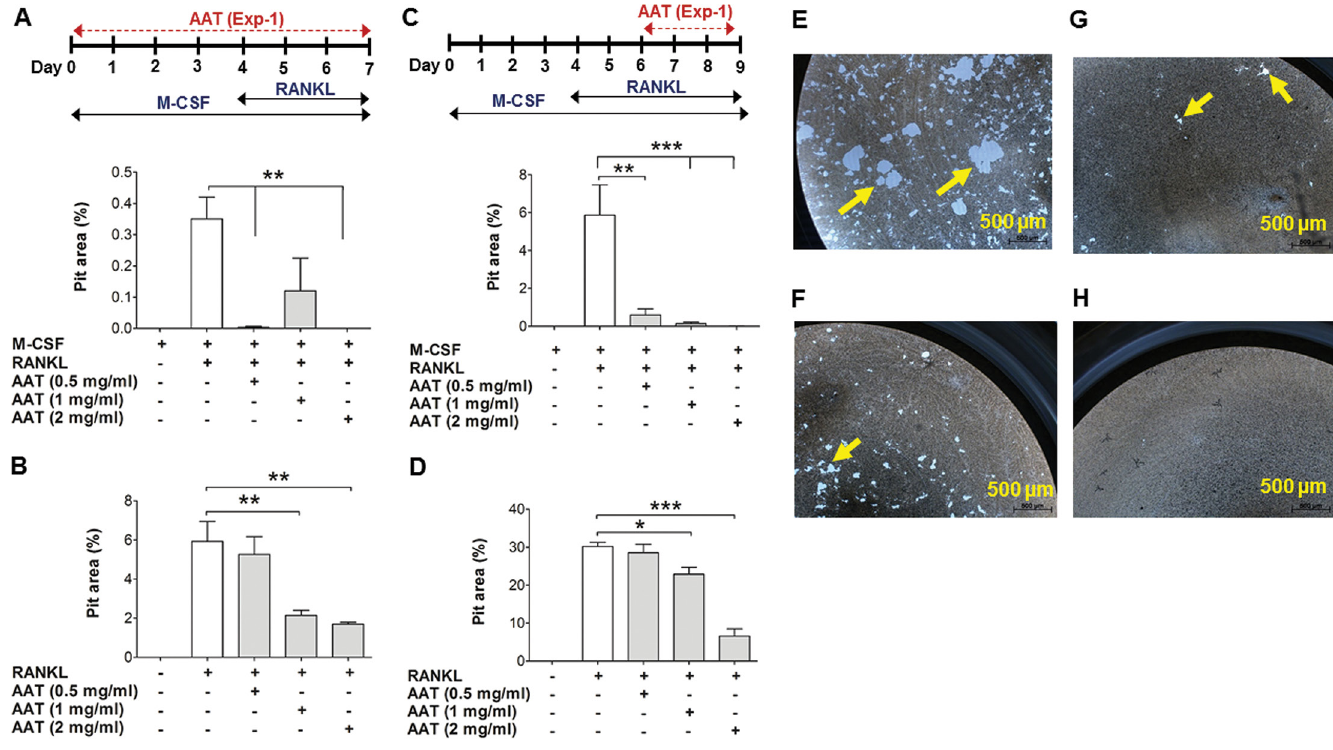
Figure 6. AAT dose-dependently inhibits osteoclast function. (A) Percentage of pit area resorbed by osteoclast cells derived from BMM cells. Osteoclast cells were generated on 96-well osteo assay surface plate using M-CSF (d 0–7) and RANKL (d 4–7). Different concentra- tions of AAT as indicated were added from d 0–7 according to Exp-1 (which is diagrammatically mentioned in Figure 1A). (B) Percent- age of pit area resorbed by osteoclast cells derived from RAW 264.7 cells. Cells were treated with RANKL (d 0–6) on 96-well osteo assay surface plate. Different concentration of AAT as indicated were added from d 0–6. (C) Percentage of pit area resorbed by osteoclast cells derived from BMM cells. Here, BMM cells were first treated with M-CSF (d 0–6) and RANKL (d 4–6) on tissue culture plate without AAT. At d 6, generated osteoclast cells were harvested, plated on 96-well osteo assay surface plate and treated with M-CSF, RANKL and different concentrations of AAT for an additional 3 d. (D) Percentage of pit area resorbed by osteoclast cells from RAW 264.7 cells. Cells were treated with RANKL (d 0–6) on tissue culture plate without AAT. Generated osteoclasts were harvested at d 6, plated on 96-well osteo assay surface plate and treated with RANKL and different concentrations of AAT for an additional 3 d. (E–H) Representa- tive images of pits documented in (C): (E) RANKL + M-CSF (considered as positive control); (F) RANKL + M-CSF + AAT (0.5 mg/mL); (G) RANKL + M-CSF + AAT (1 mg/mL); (H) RANKL + M-CSF + AAT (2 mg/mL). Values are means ± SEM of at least triplicate samples. Data were analyzed using one-way analysis of variance followed by Dunnett’s multiple comparison test. * P <0.05, ** P <0.001, *** P <0.0001. Scale bar = 500 μ m; yellow arrow indicates resorption AAT Inhibited Catk Activity and 7B).generated osteoclast cells from both rANkL-Induced CatK Gene BMM and RAW 264.7 cells. The generated In this study, we have shown for the Expression osteoclasts were harvested and plated on first time that AAT efficiently inhibits 96-well osteo assay surface plates with RANKL-induced osteoclast formation Since CatK plays a critical role in RANKL and M-CSF. After seeding the and bone resorption. We have demon- bone resorption, we tested the effect cells, we added different con centrations strated that AAT reduces M-CSF– of AAT on CatK activity. As shown of AAT and cultured the cells for 3 d. Our induced RANK receptor expression and in Figure 7A, AAT directly inhibited results show that AAT dose-dependently downregulates M-CSF–induced regula- CatK activity at very low concentration reduced the osteoclast-associated resorp- tory gene expression ( NF- k B and cFos ). conditions, while albumin as a control tion pit area (Figures 6C, D). Together, did not. In addition, we showed that We have also shown that AAT inhibits these data clearly demonstrate that AAT AAT treatment significantly inhibited RANKL-induced TNF- α production, inhibited osteoclast function (bone RNAKL-induced CatK gene expression CD9 expression and DC-STAMP gene resorption). (Figure expression, and CatK gene expression